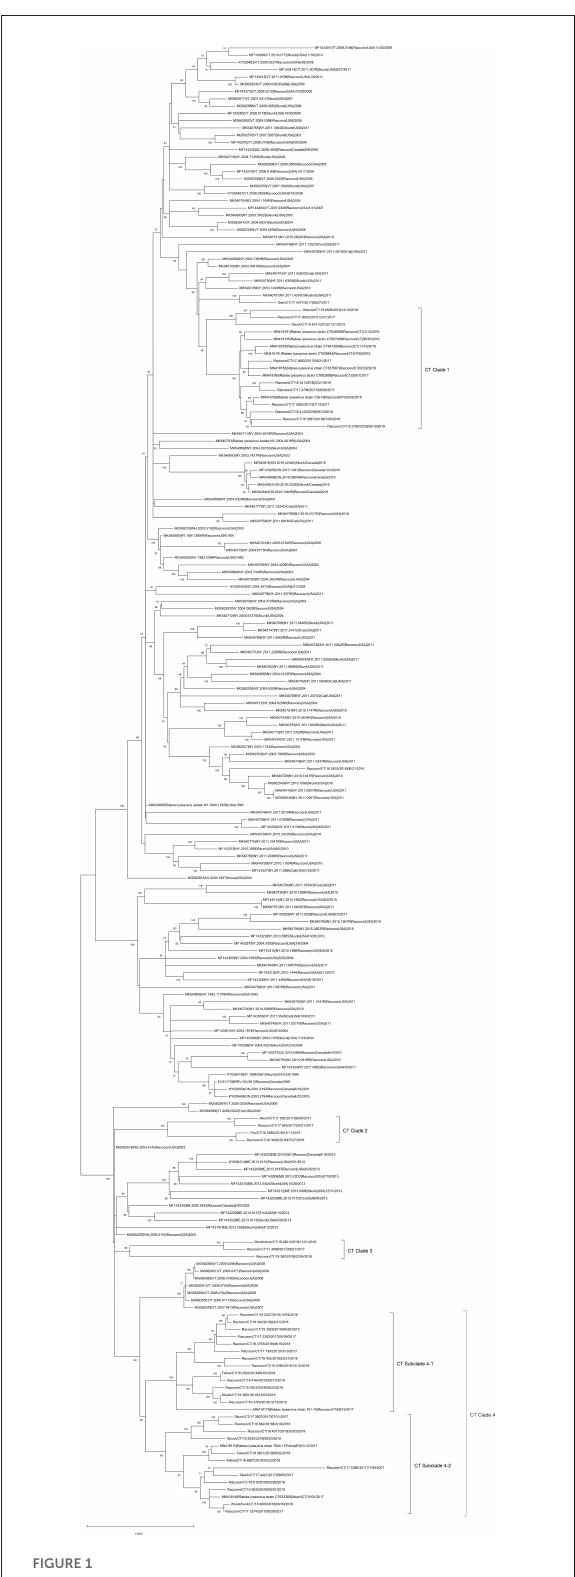
FIGURE1 Maximum-likelihood analysis of 203 complete coding sequences of RRVs identified in North America including 42